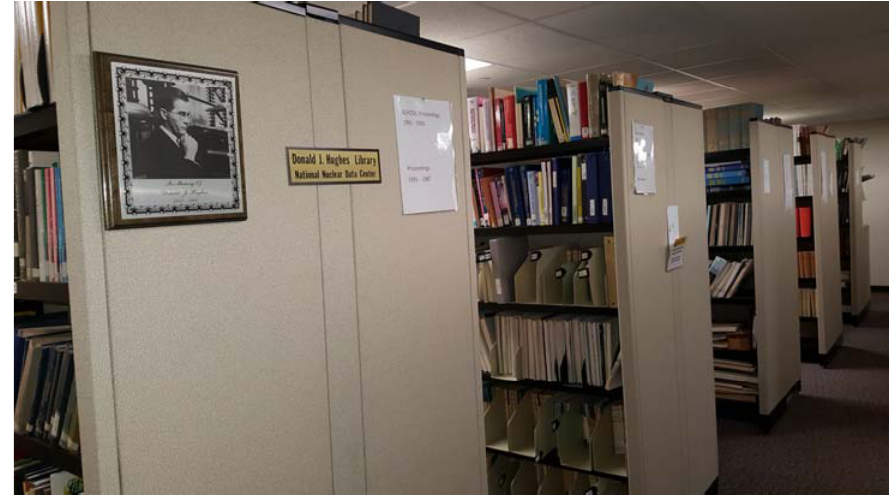
Figure 1. Donald Hughes book library at the National Nuclear Data Center, Brookhaven National